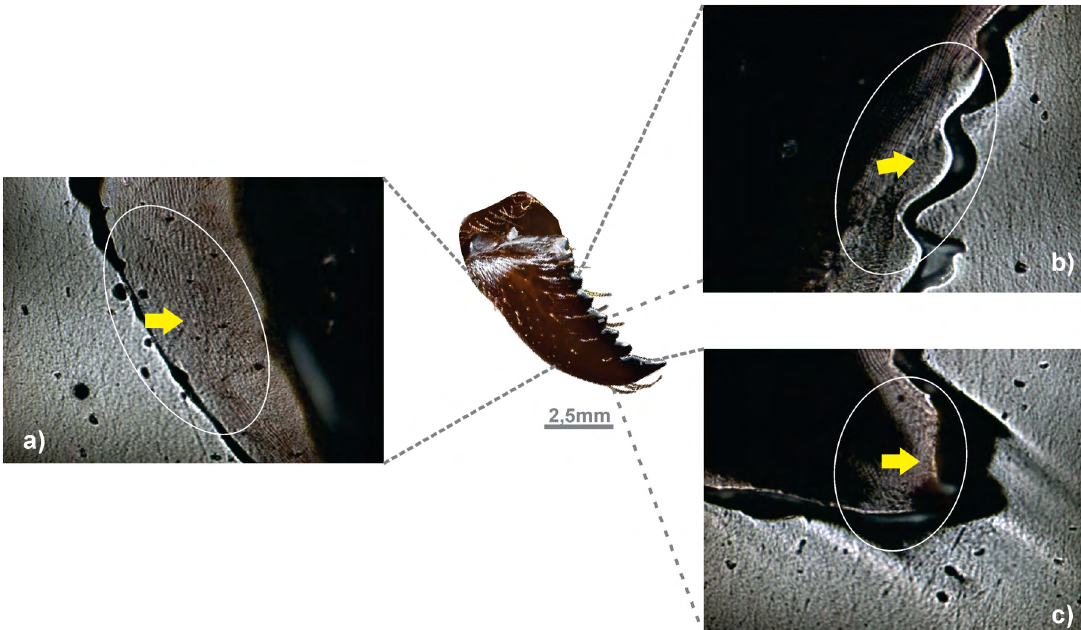
Figure 3. Nanoidentation on the regions of samples: (a) external region, (b, c) internal region of the mandible of the ant Atta laevigata , 10x magnification.